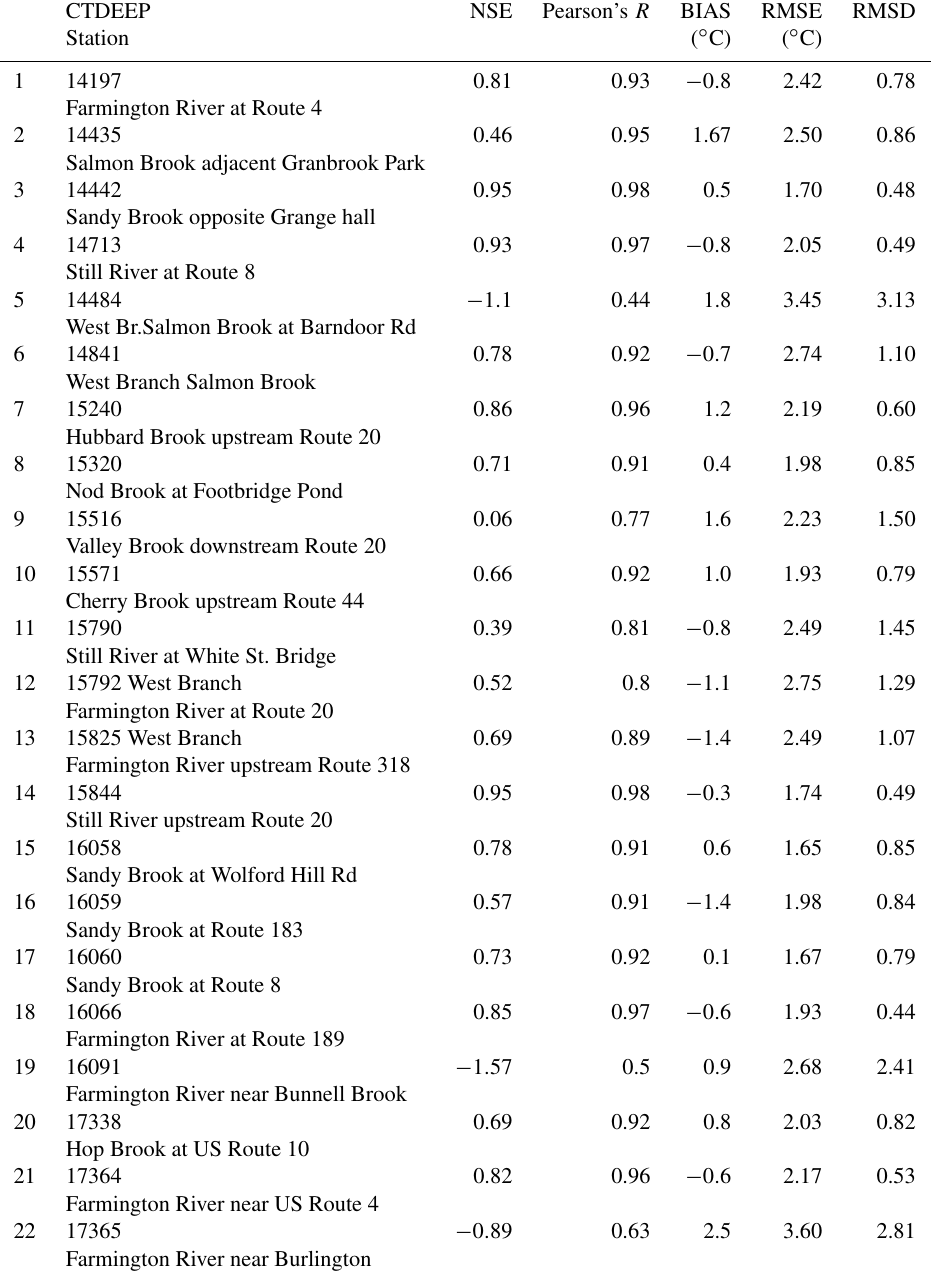
Table 5. Statistical measures for comparison of daily-averaged simulated and observed water temperatures in the Farmington River. CTDEEP NSE Pearson’s R